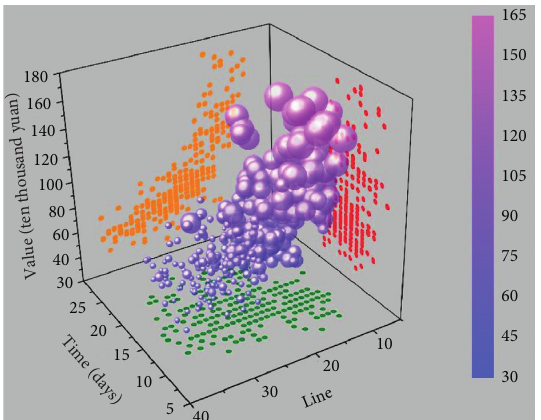
Figure 10: Value distribution of objective function after